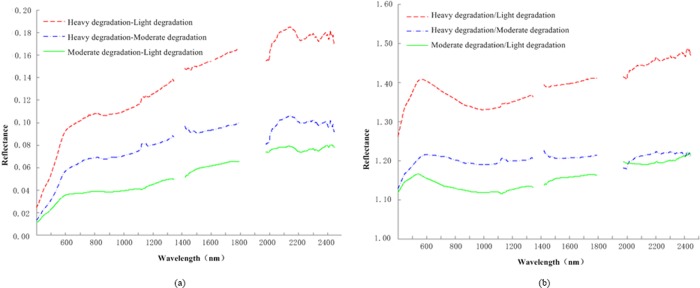
Difference curves (a) and ratio curves (b). Difference curves (a) show the difference of the average curves, which indicated the absolute quantity of reflectance between every two soil degradation grades. Ratio curves (b) show the ratio of average curves, which indicated the relative quantity of reflectance between two soil degradation grades.